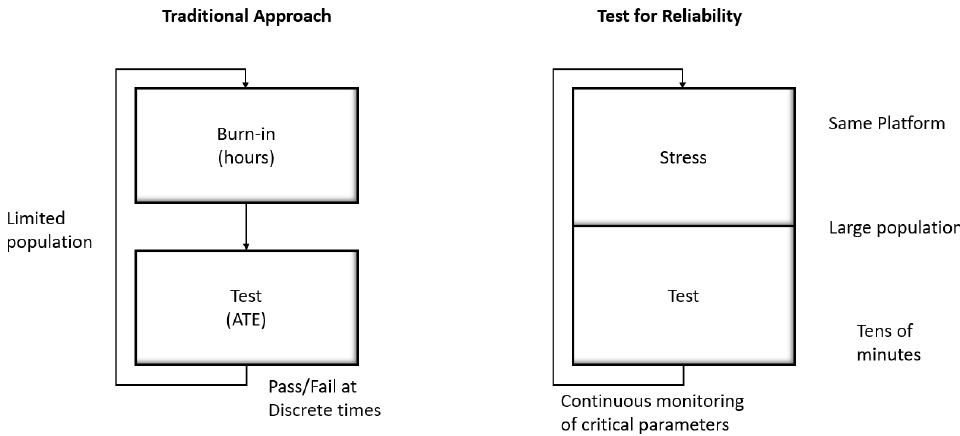
Figure 5. Comparison between the traditional approach and the Test for Reliability methodology.